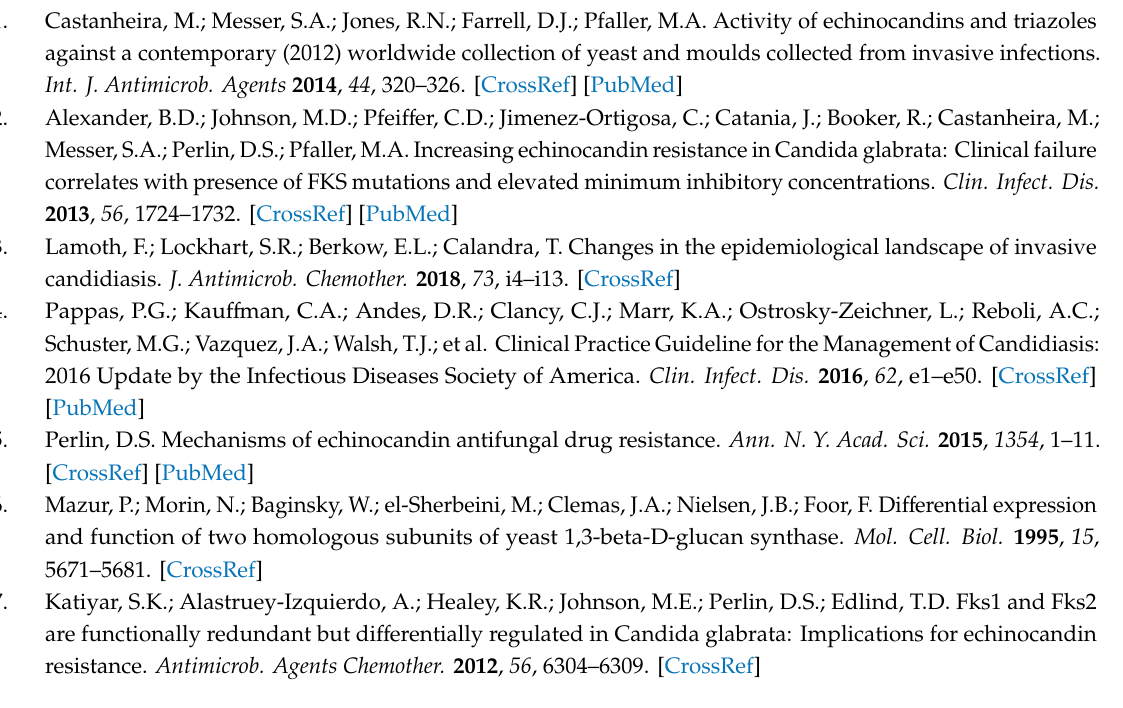
Table S1: Primers used in this